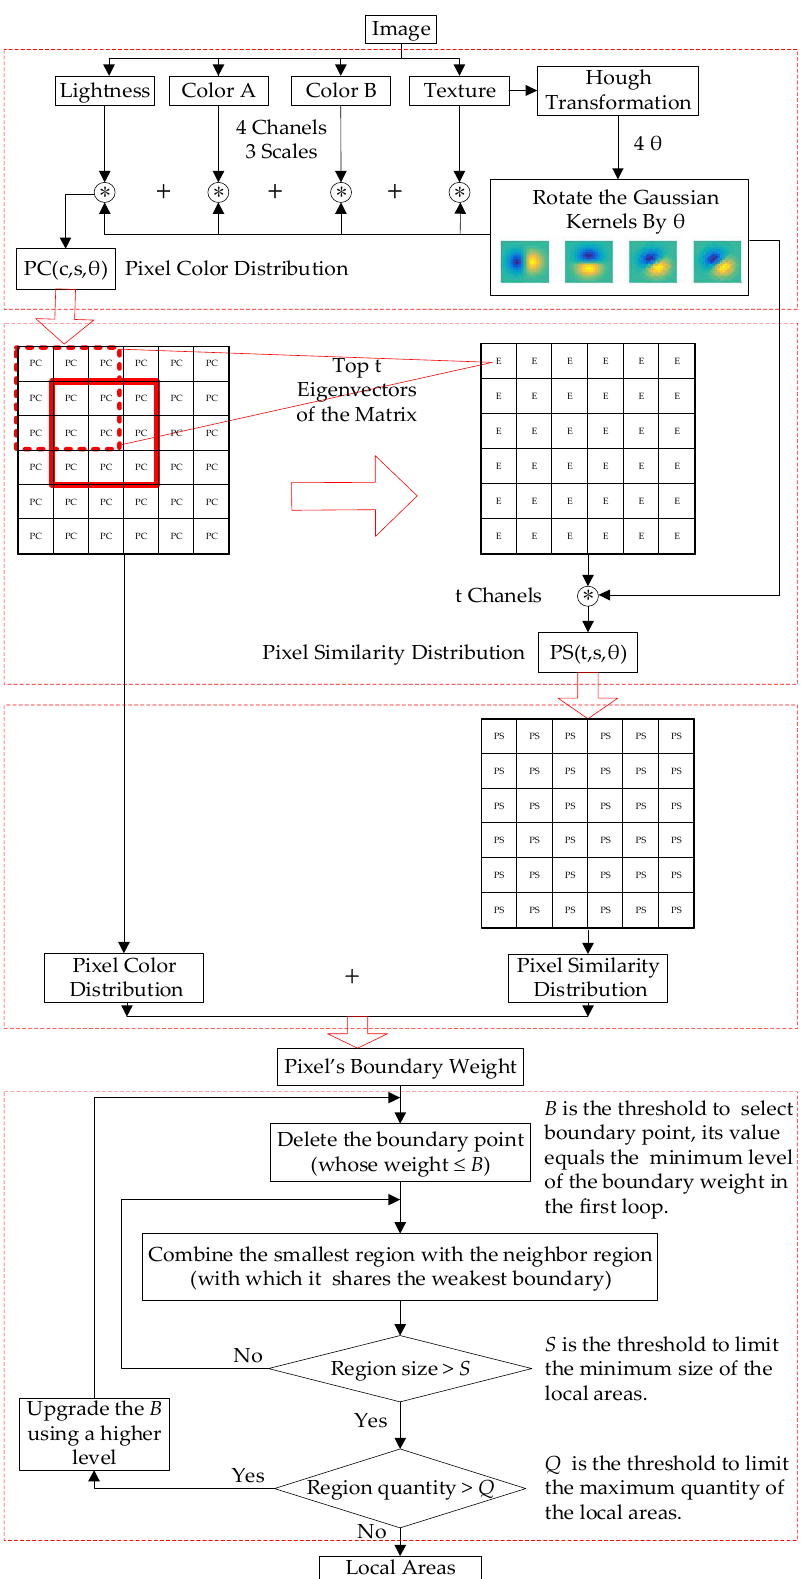
Figure 3. The procedure to segment an image into fragmented regions and combine them into local areas.